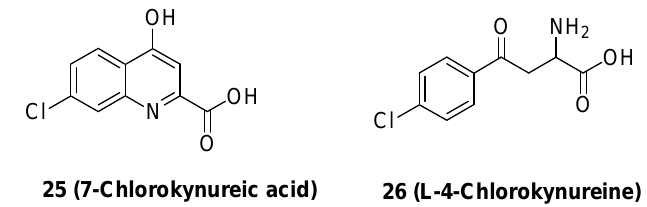
Figure 9. Chemical structures of 7-chlorokynurenic acid and its prodrug L -4-chloro- kynureine as “pseudonutrient” for LAT 1 system.